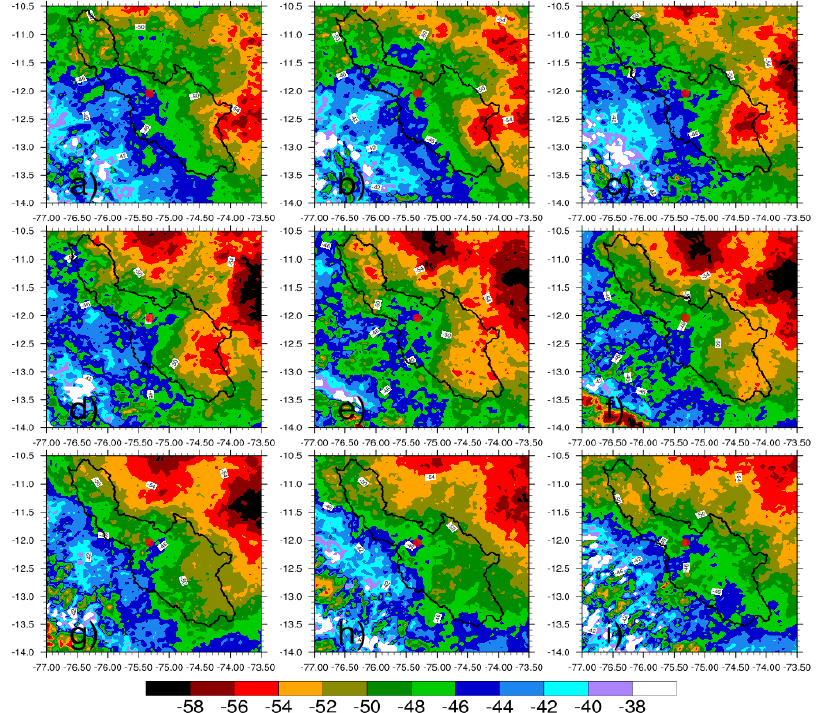
Figure 14. Same as Figure 12, ( a ) 22 LST, ( b ) 23 LST, ( c ) 00 LST, ( d ) 01 LST, ( e ) 02 LST, ( f ) 03 LST, ( g ) 04 LST, ( h ) 05 LST and ( i ) 06 LST.